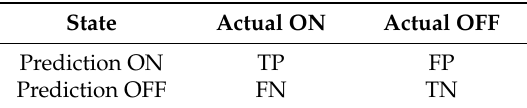
Table 1. F-score parameters description.TP: true positive; FP: false positive; FN: false negative; TN: true